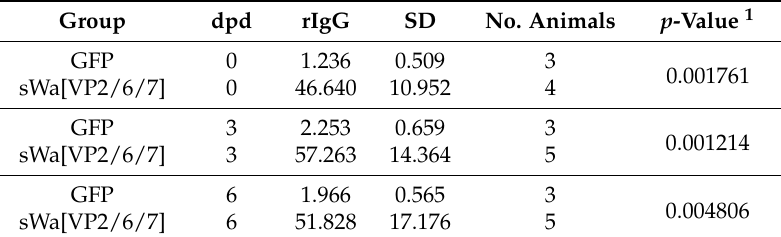
included in this study and the p -values.